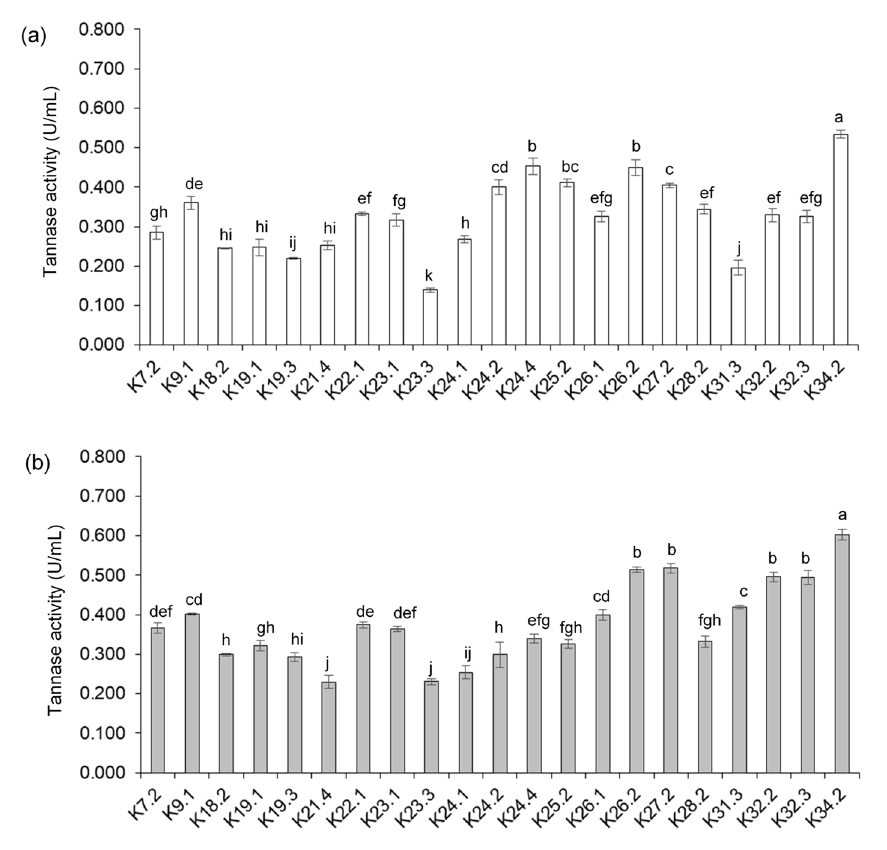
Figure 4. Tannase activity of 21 tannin-tolerant Bacillus spp. from culture broth containing 0.5% ( w / v ) tannic acid incubated at 37 °C for 24 h ( a ) and 48 h ( b ).